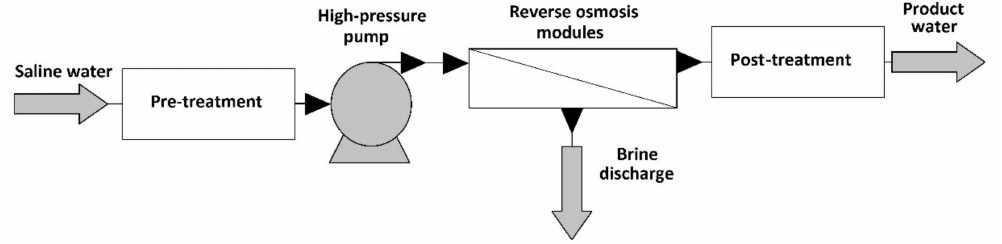
Figure 3. Schematic flowsheet of reverse osmosis plant